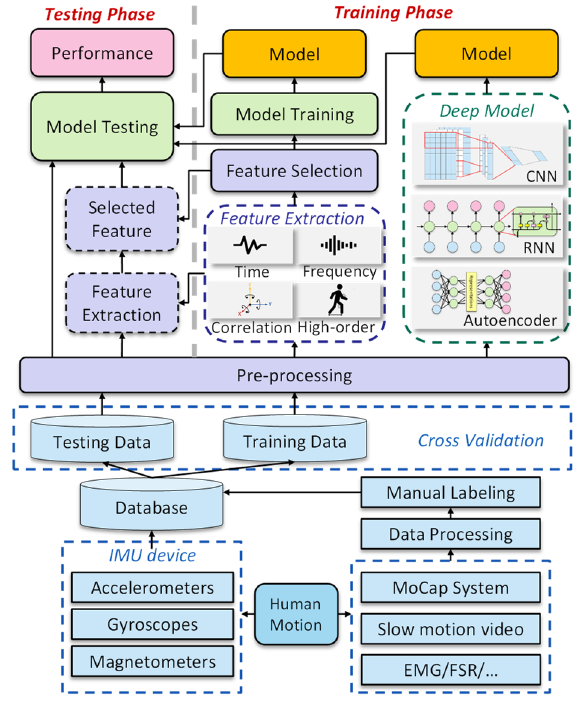
Figure 5. Machine learning-based method.